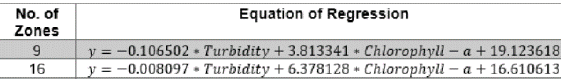
Table 7: Comparison of Nine and Sixteen Zones